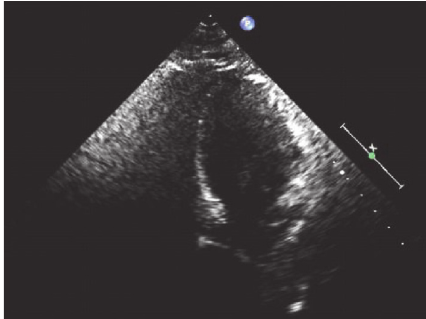
Figure 6: Mid-ventricular akinesis, end diastole (postop pics).